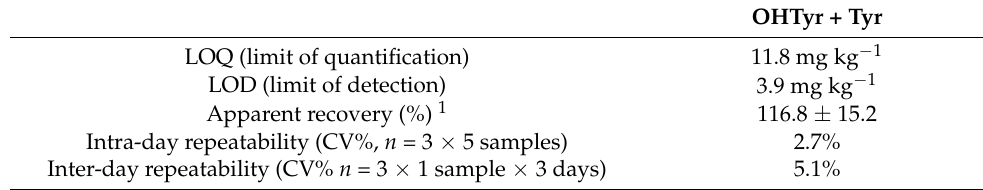
Table 6. Figures of merit of the method of analysis of total OHTyr + Tyr in EVOOs by NADES extraction and UV analysis of the second derivative